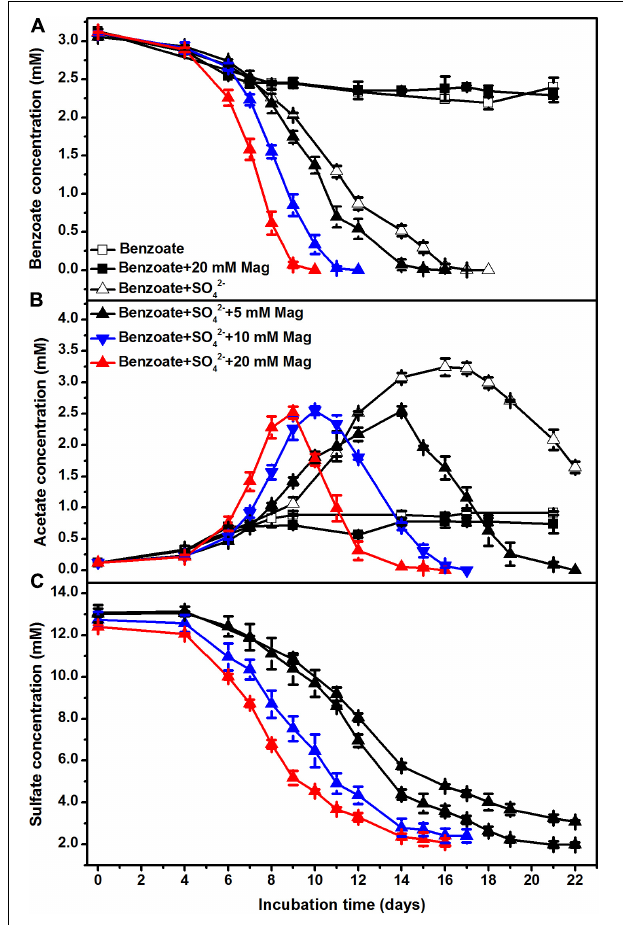
FIGURE 2 | The effect of magnetite loading on sulfate-dependent benzoate degradation: (A) benzoate degradation; (B) acetate concentration; (C) sulfate reduction. The concentrations of magnetite were tested at 5, 10, and 20 mM. Mag denotes